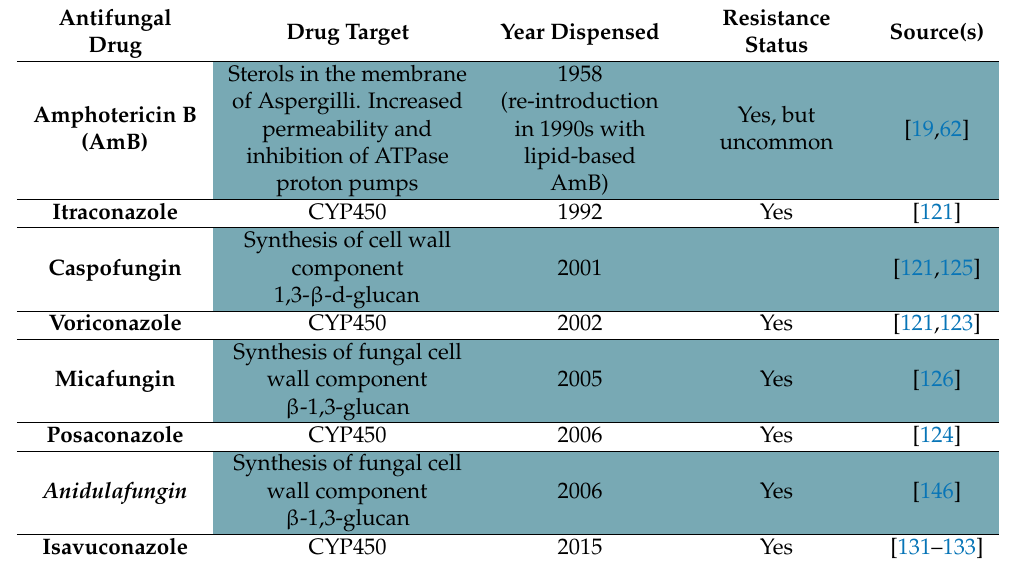
Table 1. Common antifungal drugs used as aspergillosis treatment. Itraconazole and fluconazole were part of the first generation of azole drugs. Second generation of azoles include voriconazole, posaconazole, and isavuconazole. CYP450 as target means that the ergosterol synthesis is affected, which is essential for the cell membrane. This is performed by inhibiting 14 α lanosterol demethylase, on which CYP450